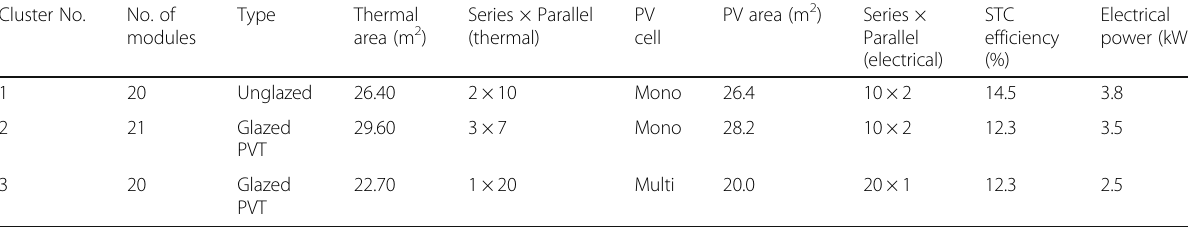
Table 1 Thermal and electrical characteristics of the 3 different Clusters Cluster No.